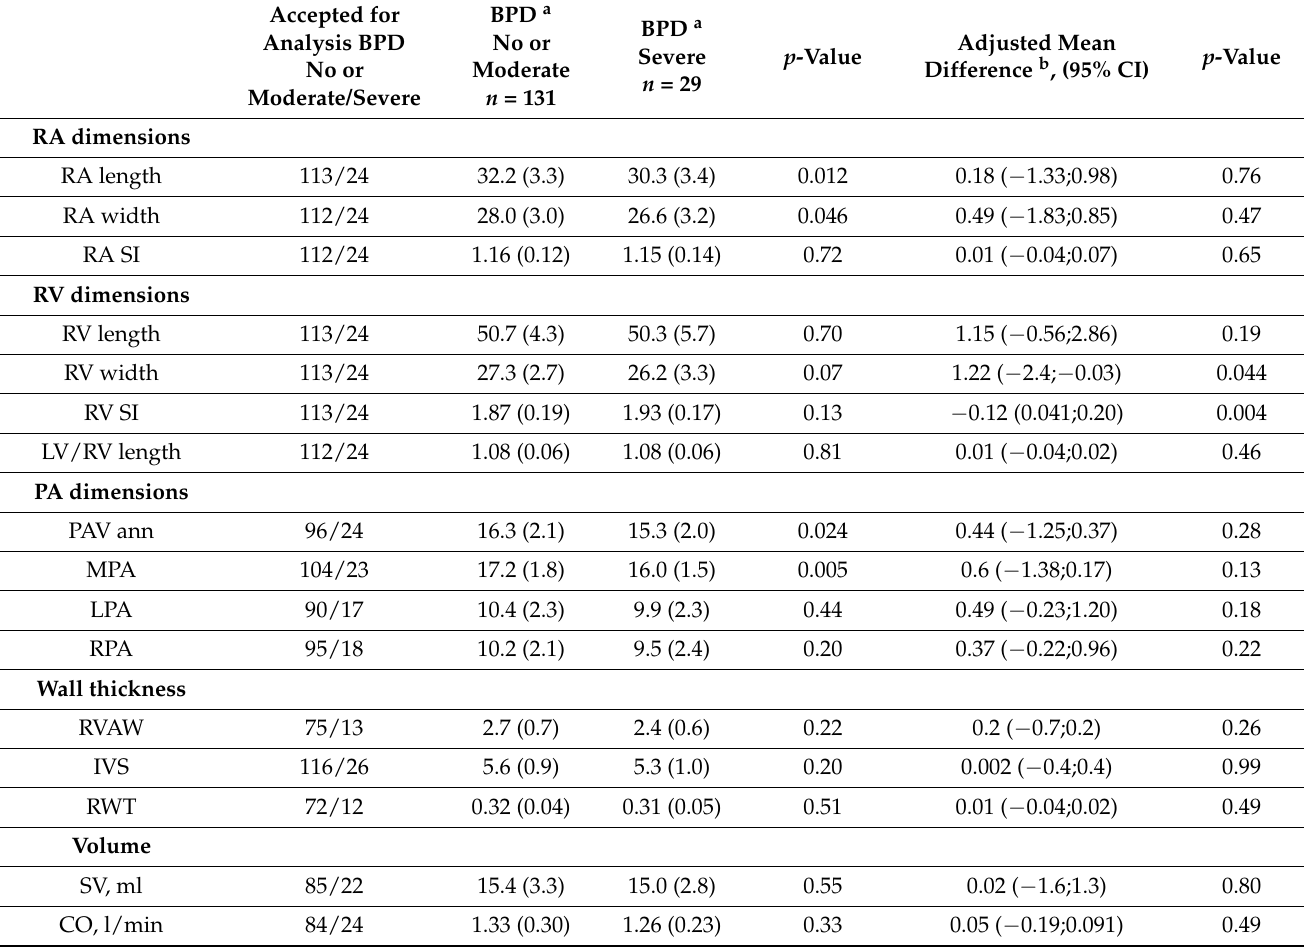
Table 6. Right heart dimensions and volumes in 6.5-year-old children born extremely preterm (EXPT) stratified by a neonatal diagnosis of no or moderate bronchopulmonary disease (BPD) versus severe